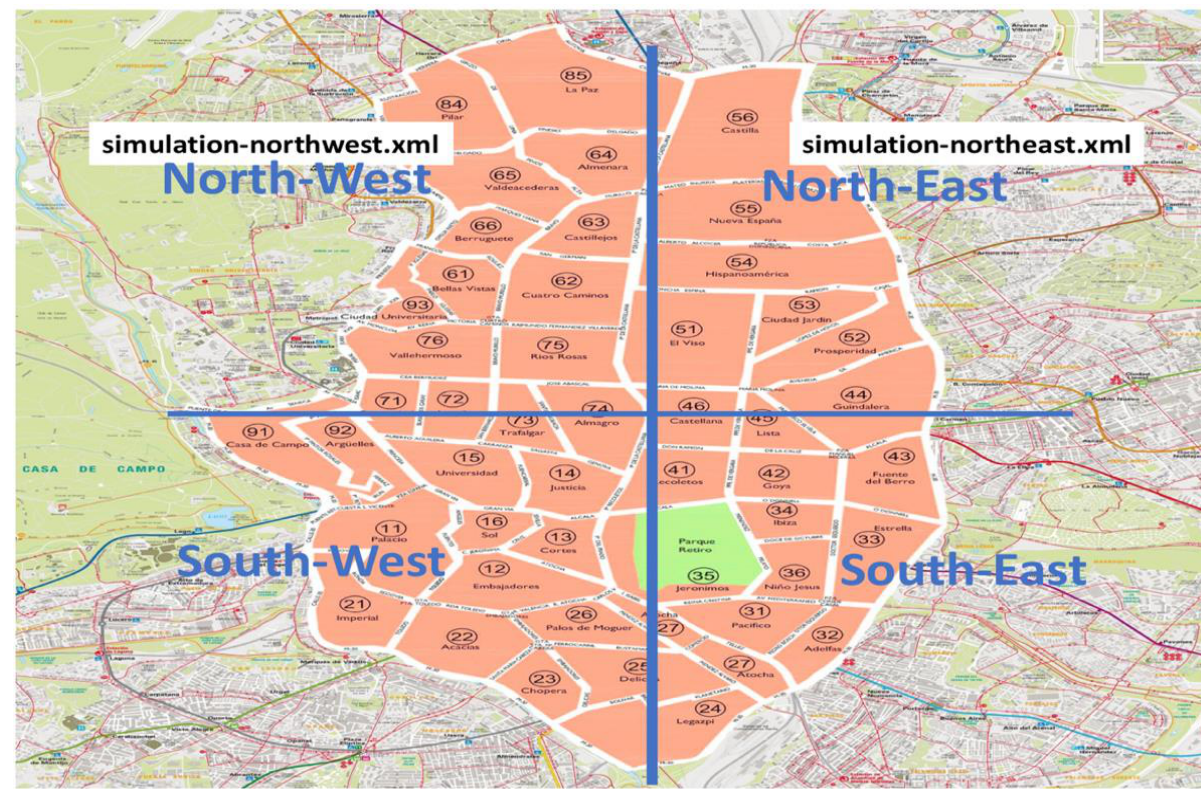
Figure 25. Modular and hierarchical distribution to model an IoT parking system for the city of Madrid.